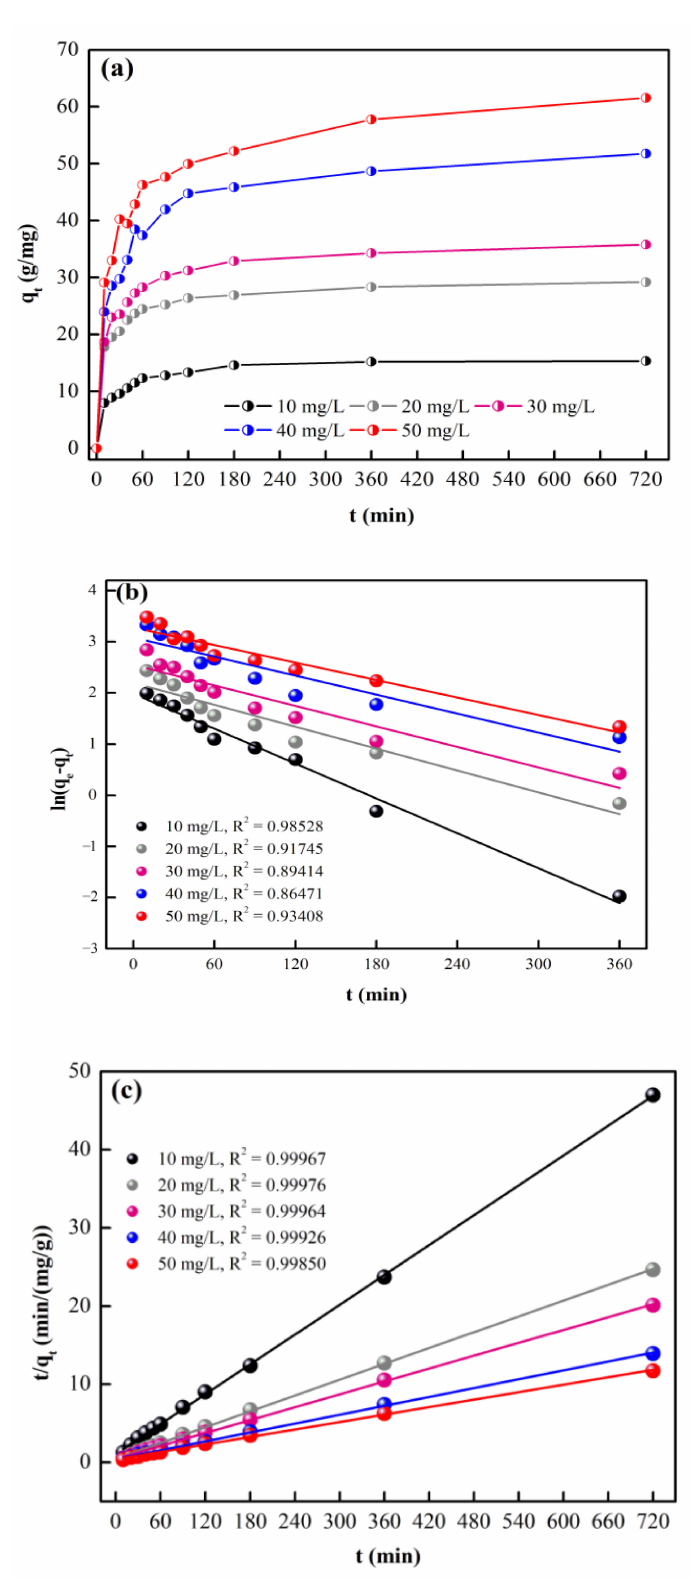
Figure 4. ( a ) History of adsorption capacities under different initial CTC concentrations, ( b ) linear plot of pseudo-first-order kinetics, and ( c ) linear plot of pseudo-second-order